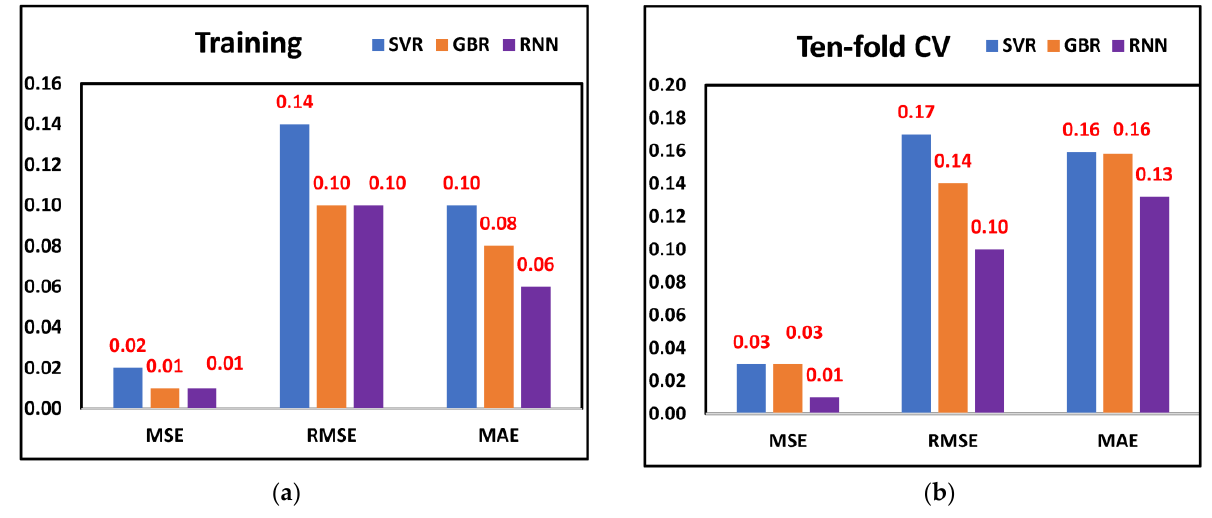
Figure 6. Prediction errors from Dragonfly selected features ( a ) Training ( b ) Ten-fold.